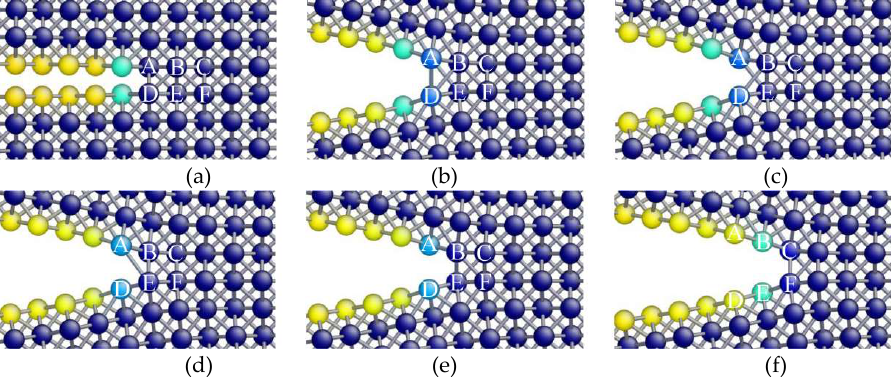
Figure 4. Snapshots of the Cu nanoplate crack tip structure with a crack length of 25 c corresponding